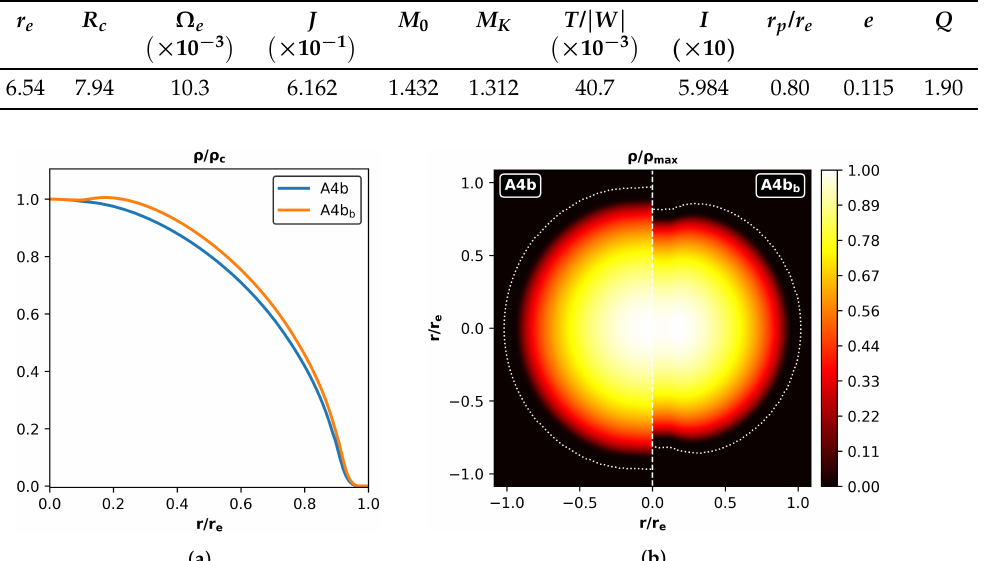
Table 3. Physical quantities (see Tables 1 and 2 for their definitions) for model A4b b (same rotation law and parameters as model A4b but with a double central rotation rate (see the text for more details).